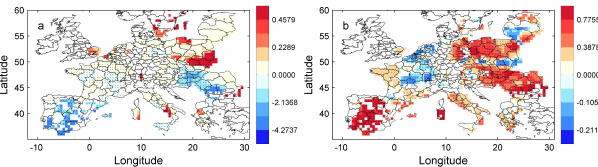
Figure 7. Spatial patterns of the general climate sensitivity of bar- ley yield. Climate sensitivity of barley yield to the mean growing- season temperature (a) and total growing-season water availability index (b) was estimated by the slope of linear regression during the 1975–2009 period. Significant slopes were marked by black points. Blank regions indicate that there is intensive irrigation (with irri- gated area fraction ≥ 15%), no crop yield records or a very low ( < 5%) fraction of croplands in those pixels. Figure 8. Spatial patterns of the linear trends in moving climate sensitivities of barley yield. The linear trends in moving climate sensitivity of barley yield to the mean growing-season temperature (a) and total growing-season water availability index (b) were esti- mated by the Theil–Sen slope method using a 10yr sliding window with 1yr lag during the 1975–2009 period. Significant trends were marked by black points. Blank regions indicate that there is inten- sive irrigation (with irrigated area fraction ≥ 15%), no crop yield records or a very low ( < 5%) fraction of croplands in those